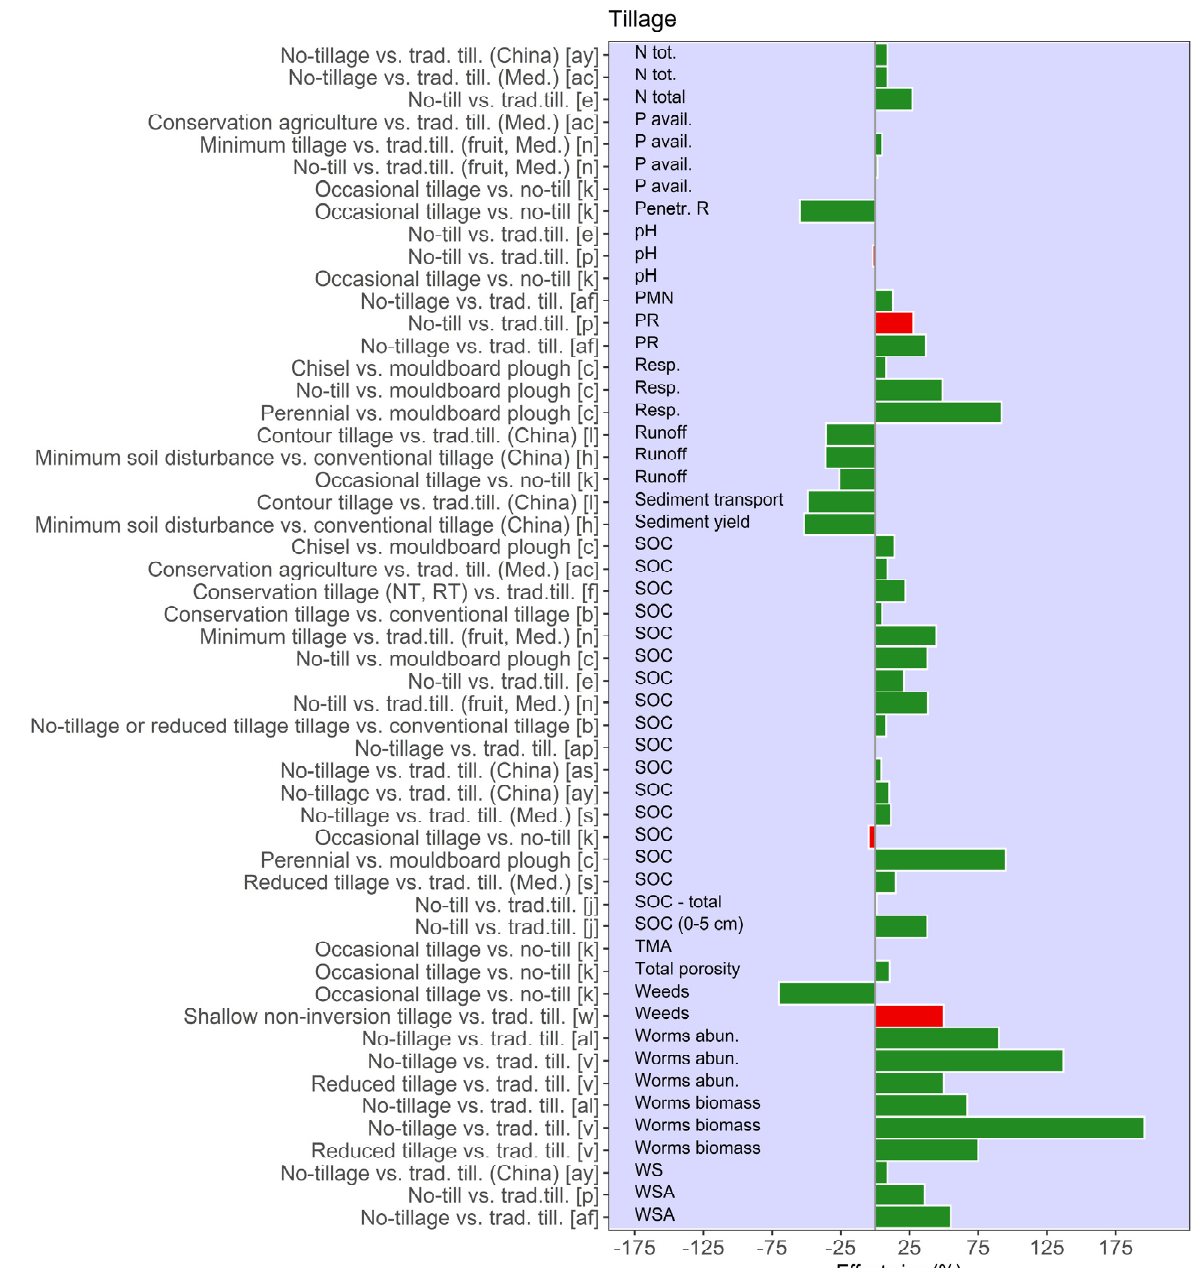
Figure 5. Overall response ratios reported in meta-analysis studies on tillage grouped per area of interest (light green: agronomic; light blue: soil quality; light orange: resource use efficiency; light brown: economic (no data); light yellow: environmental impacts). The management or treatment comparison is indicated outside the y-axis and the variable to which the data refer are listed inside the y-axis (abbreviations can be found in Table A1). Green bars indicate improvement, red bars indicate worsening. See also Table S5. [a]: [112]; [b]: [61]; [c]: [123]; [d]: [123]; [e]: [124]; [f]: [125]; [g]: